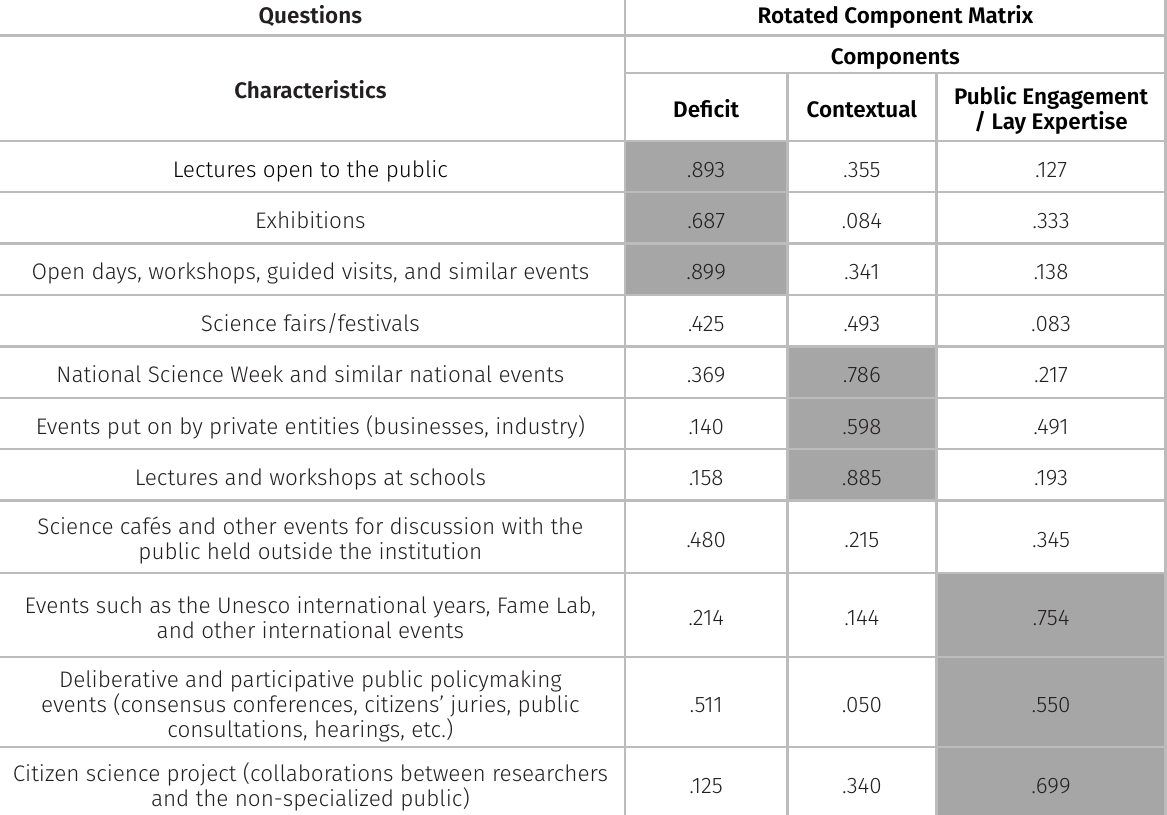
Table I. Matrix of components of participation as an organizer or collaborator in science communication